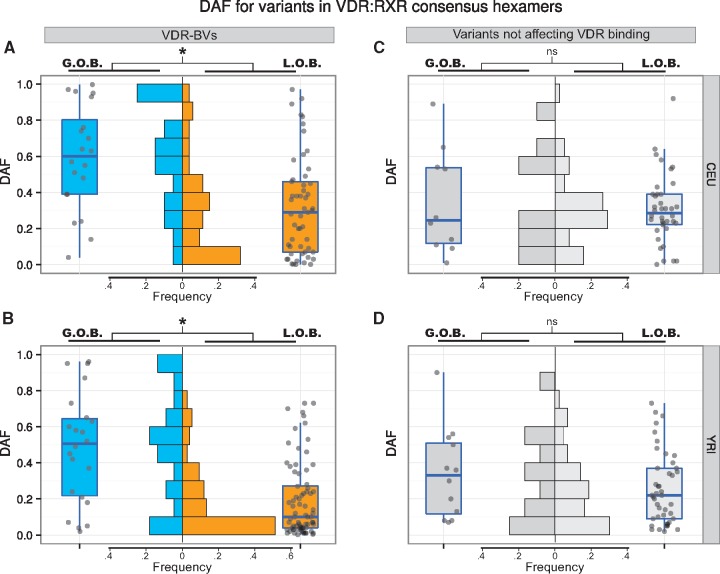
Evolutionary conservation of VDR-BVs at RXR::VDR consensus motifs. The diagrams show distributions of the Derived Allele Frequency (DAF) for variants in RXR::VDR consensus motifs within reproducible CPo3 binding peaks. DAF values are separated by ethnicity (A and C: CEU; B and D: YRI); variants are separated by their effect on VDR binding affinity (A and B: VDR-BVs; C and D: 1000 Genomes variants carried by the LCL samples which do not test for significant asymmetric binding and are not, therefore, VDR-BVs). Within each of the four panels, variants are split in two groups, based on their effect on VDR binding affinity direction (whether GOB or LOB). For all quadrants, only DAFs for variants hitting hexamer positions (i.e. hitting either the RXR recognition element at positions 1-6 or the VDR recognition element at positions 10-15) in the RXR::VDR motif are shown. An asterisk indicates significance (non-parametric Wilcoxon rank sum tests, α = 0.05). A: Wilcoxon rank sum test, P = 2.8 × 10−4. B: Wilcoxon rank sum test, P=4.6 × 10−5. C and D: P = 0.55 and P=0.14, respectively. ns = not significant.